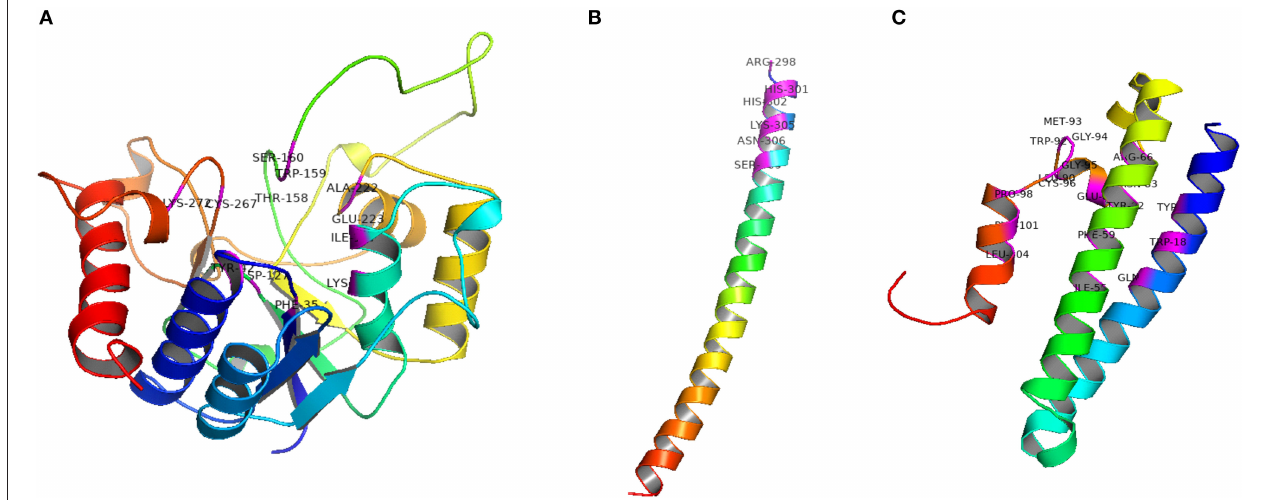
FIGURE 3 | 3D structure of candidate genes/proteins associated with seed longevity in legumes. (A) GolS1 (Active site residues are Ile107, Lys111, Asp127, Thr158, Trp159, Ser160, Ala222, Glu223, Cys267, Lys272, Phe35, Ala37, Tyr42 (B) ABI5 (Active site residues are Arg298, His301, His302, Lys305, Asn306, Ser309), (C) DOG1 (Active site residues are Phe101, Leu104, Tyr15, Trp18, Met19, Gln22, Ile55, Phe59, Tyr62, Arg66, Tyr77, Asn83, Glu87, Leu90, Trp92, Met93, Gly94, Gly95, Cys96, Pro98).